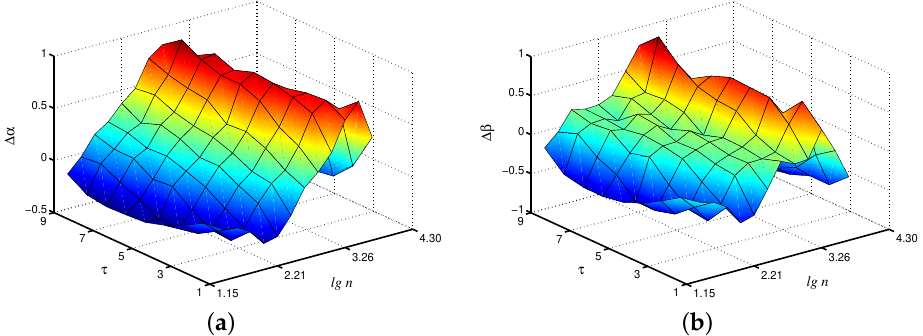
Figure 5. A typical example of differences ∆ α and ∆ β in local scaling exponents α ( a ) and β ( b ) between waking and artificial sleep states. Improvements by 32% ( a ) and 41% ( b ) compared to τ = 1 are observed.